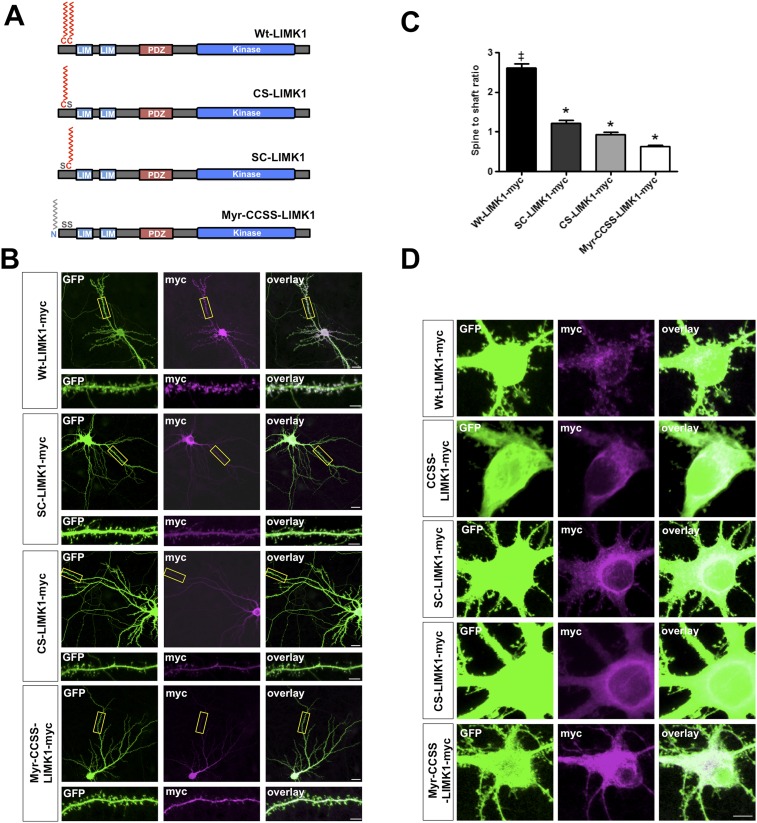
Dual palmitoylation is necessary for LIMK1 spine targeting.(A) Schematic of LIMK1 single palmitoylation site mutants (SC-LIMK1, CS-LIMK1) and a LIMK1 mutant in which a sequence directing addition of the lipid myristate is added to the N-terminus of CCSS-LIMK1 (Myr-CCSS-LIMK1). (B) Representative images of hippocampal neurons (DIV18), transfected to express the indicated myc-tagged LIMK1 constructs from A, plus GFP (morphology marker), immunostained with the indicated antibodies. Scale bar: 20 μm. Lower panels show magnified images of dendrites (scale bar: 1 μm). (C) Quantified spine targeting ratio for n = 30 neurons per condition from B confirm that only wt-LIMK1-myc is enriched in spines. *:p < 0.05, ANOVA with Dunnett's post hoc correction. (D) Confocal images of cell soma regions from the same conditions as in B show apparent enrichment of SC-LIMK1 and CS-LIMK1 on intracellular membranes, raising the possibility that the remaining cysteine is palmitoylated in these mutants.